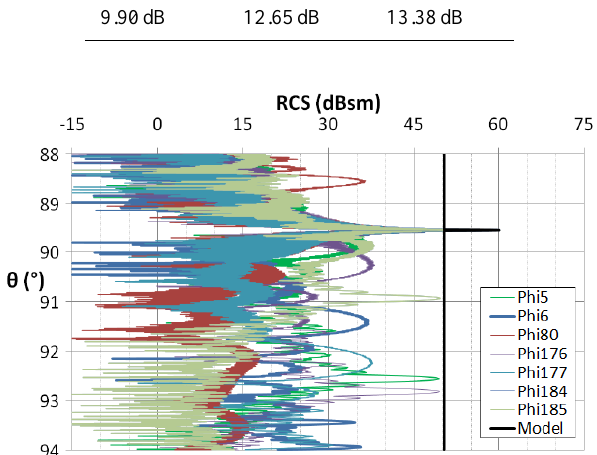
Figure 9. Vertical sections of RCS patterns ( Ф = 5º, 6º, 80º, 176º, 177º, 184º, 185º) for wind turbine model 1 (Frequency 5.65 GHz, Rotor position P000) and result of the proposed model (black line).